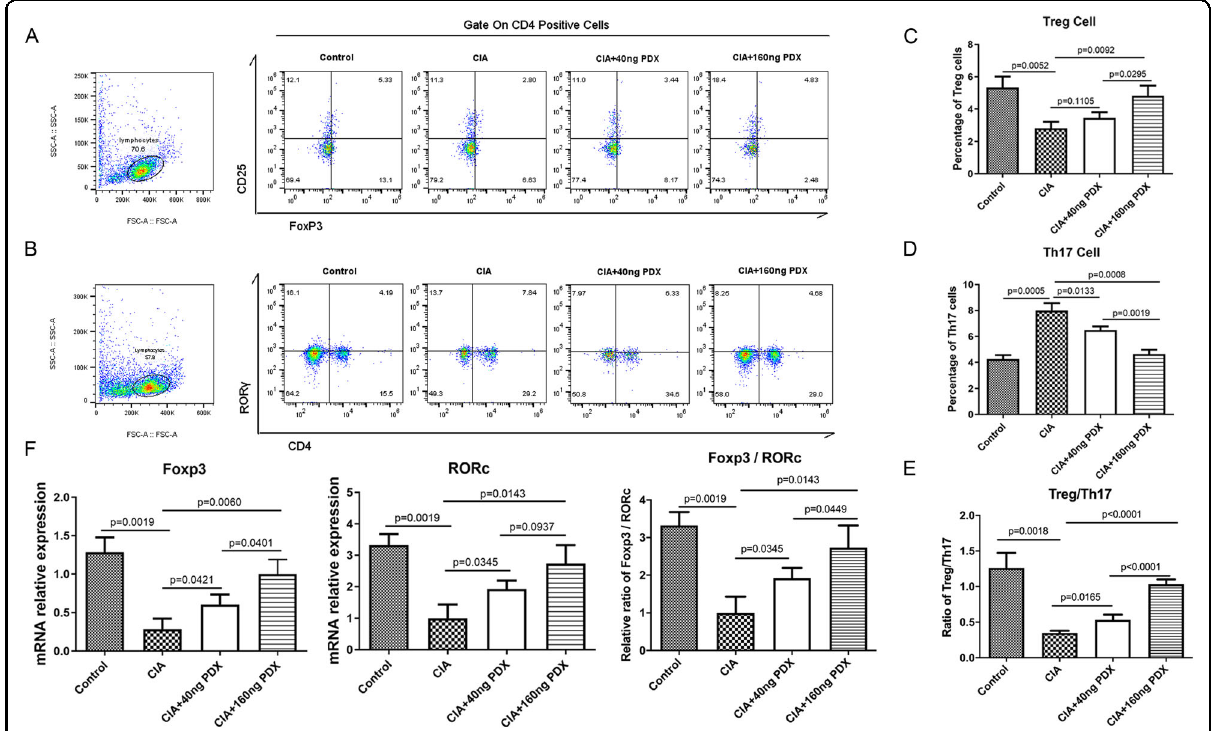
Fig. 3 PDX regulated Treg/Th17 cell balance in CIA mice. A – D Percentages of T h 17 cells and Tregs from PDX-treated CIA mouse lymph nodes as shown by FCM (F[4, 12] = 61.37 and F[4,12] = 14). E Ratio of Tregs to T h 17 cells from PDX-treated CIA mice (F[4,12] = 72.83). F mRNA expression of ROR γ and FOXP3, and FOXP3/ROR γ ratio, in lymphocytes from PDX-treated CIA mice, as shown by RT-qPCR (F[4, 12] = 16.86 for ROR γ , F[4,12] = 21.32 for FOXP3 and F[4,12] = 19.56 for FOXP3/ROR γ ). Data were presented as means ± SD. Differences among the three groups were assessed using